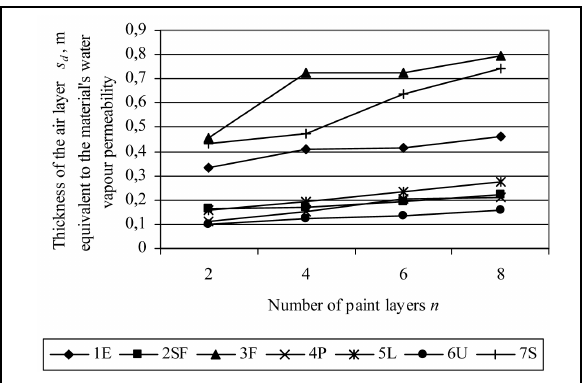
Fig 3. Dependence of the air layer thickness s building material’s water vapour permeability on the number of the paint layers